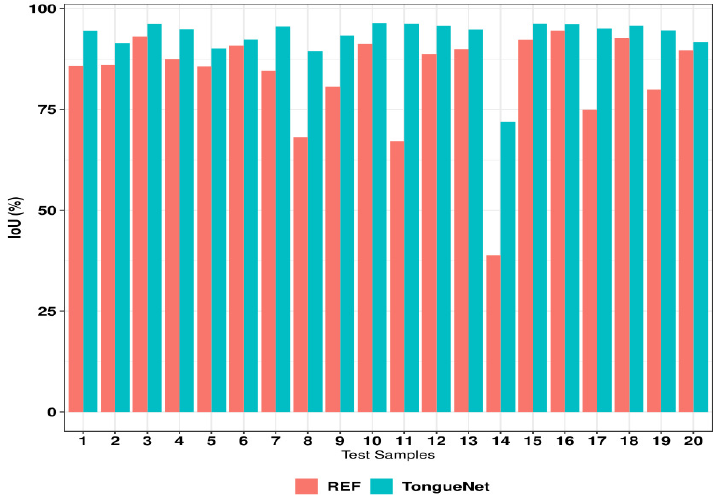
Figure 12. IOU comparison of TongueNet (green) and REF